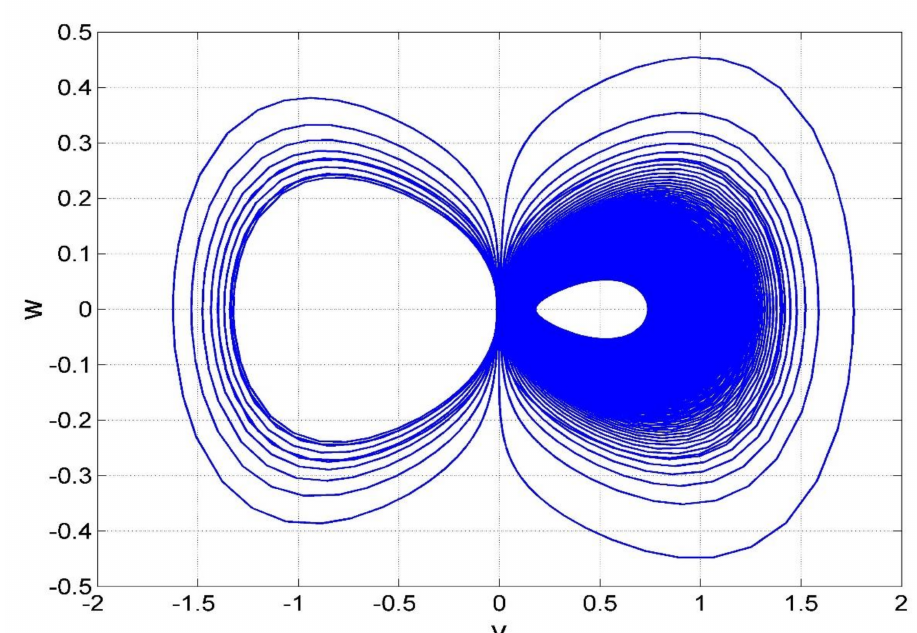
Figure 3. The 2-D signal representation of the chaotic model (4) in the ( v , w ) − plane for the parameters ( a , b , c ) = ( 14,0.5,1.4 ) and the initial state ( u ( 0 ) , v ( 0 ) , w ( 0 )) = ( 0.05,0.05,0.05 )